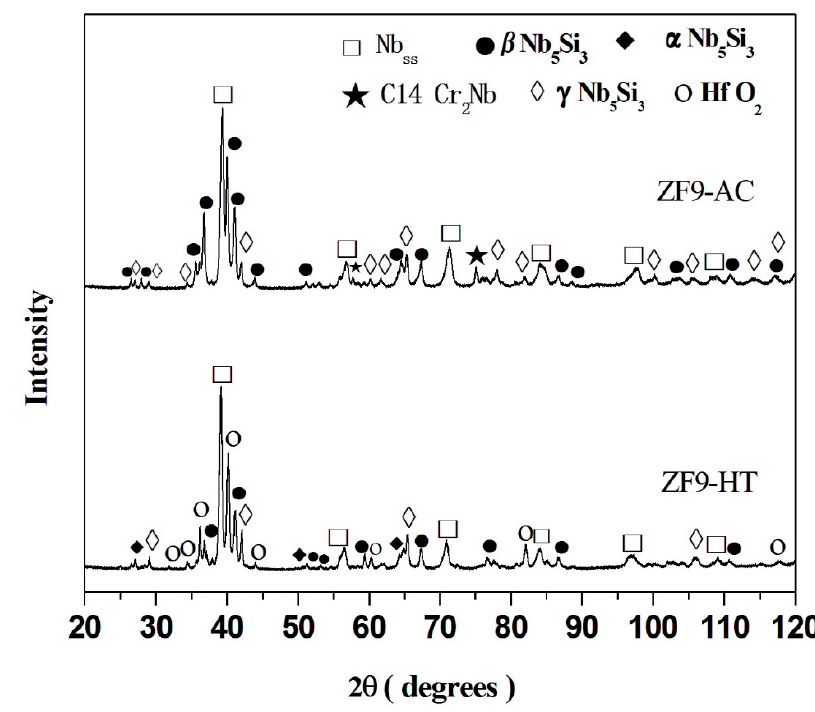
Figure 4. X-ray diffractograms of the as cast (AC) and heat treated (HT) (1400 °C/100 h) alloy ZF9.